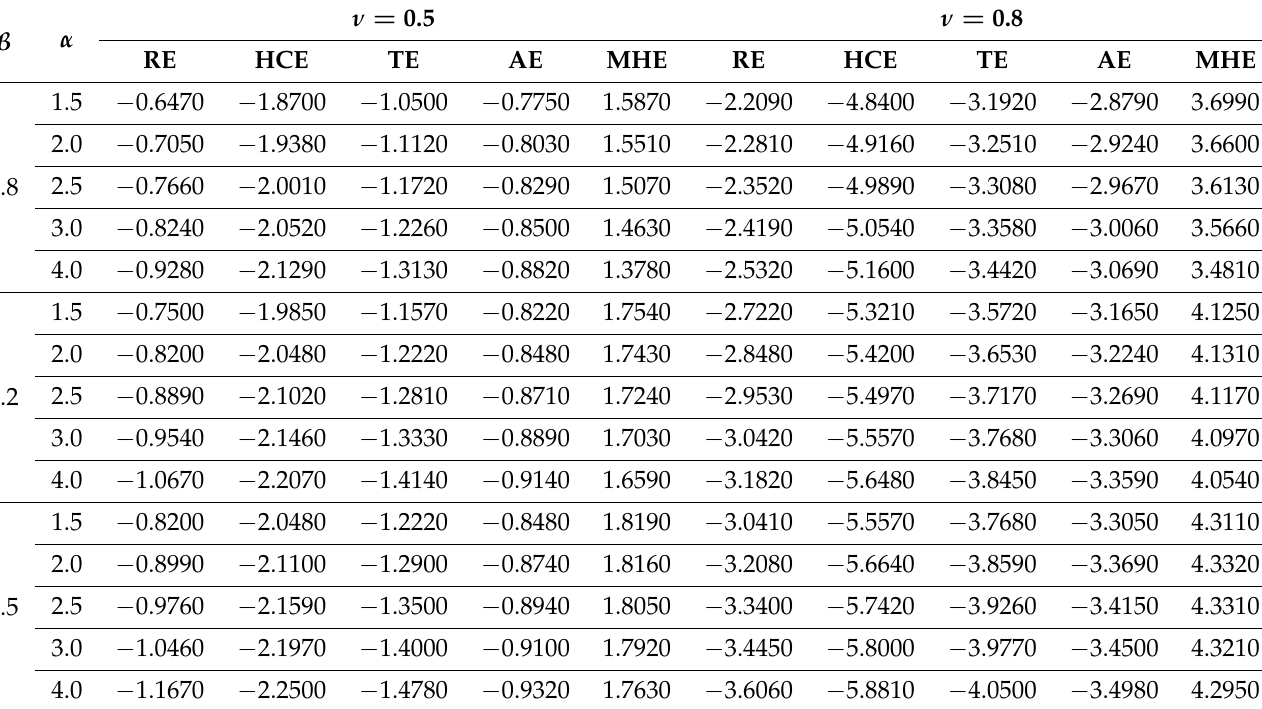
Table 2. Some numerical values of entropy for the UEPD at λ = 0.5, ν = 0.5 or